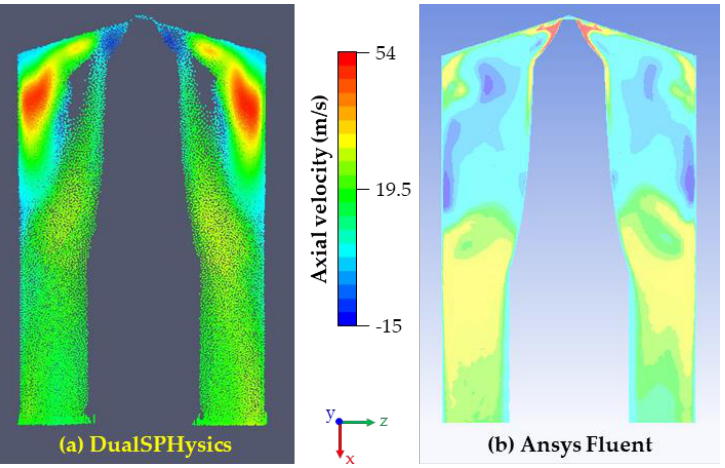
Figure 3. Color plots of axial velocity on a longitudinal section of the fluid domain: comparison of results obtained with ( a ) open-source DualSPHysics code and ( b ) commercial code Ansys Fluent .